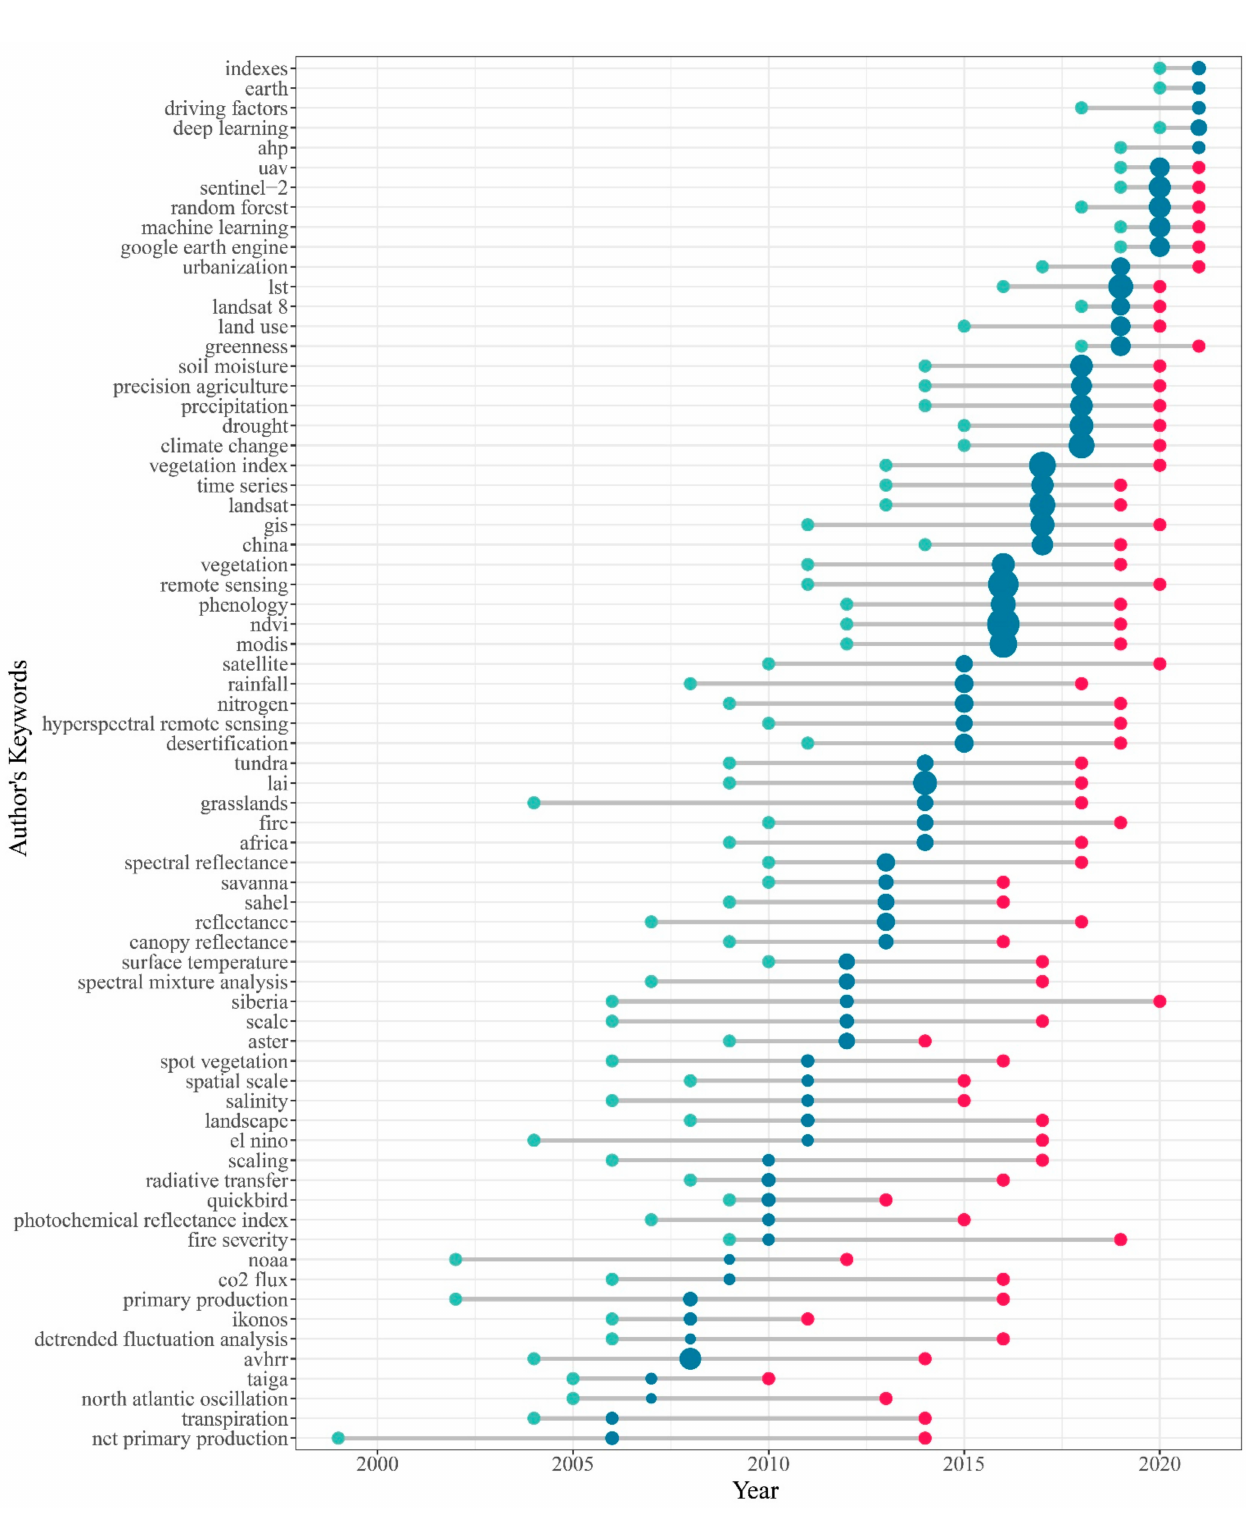
Figure 8. Temporal trends in author